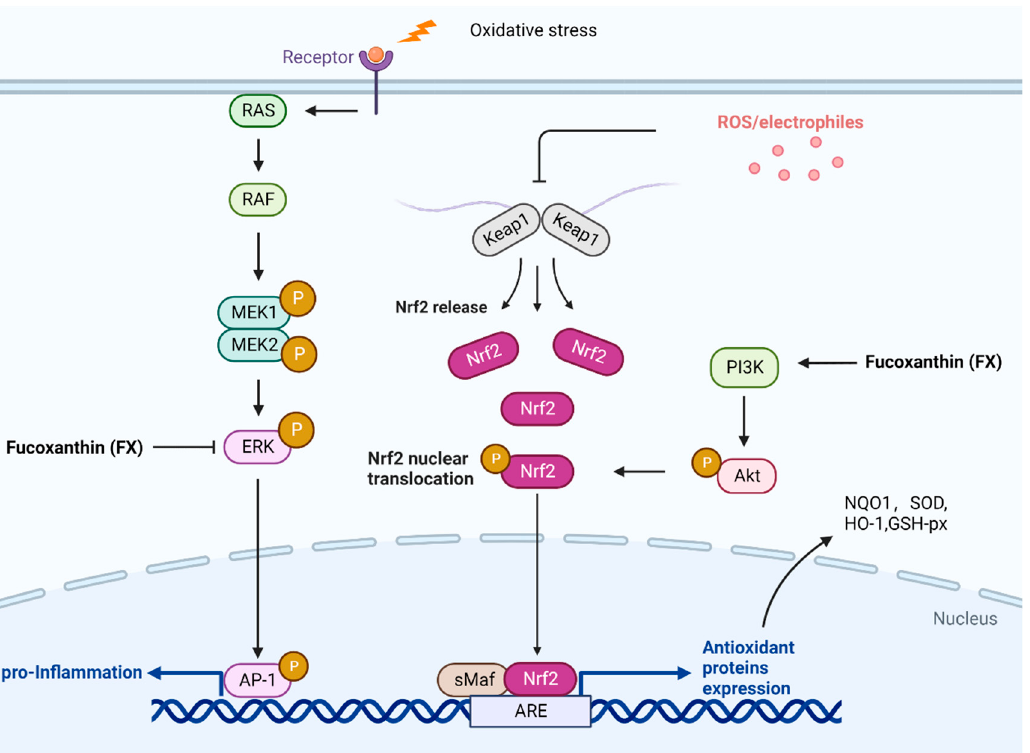
Figure 3. Pathway underlying the antioxidant effects of fucoxanthin (FX). Cellular oxidative stress leads to the expression of intracellular reactive oxygen species (ROS) and some inflammatory factors, resulting in cellular damage. FX can reduce the release of inflammatory factors by inhibiting the ERK pathway. Furthermore, FX activates Nrf2 via PI3K/Akt and upregulates antioxidant protein expression, such as NQO1, SOD, HO ‐ 1, and GSH ‐ px, resulting in antioxidant activity.